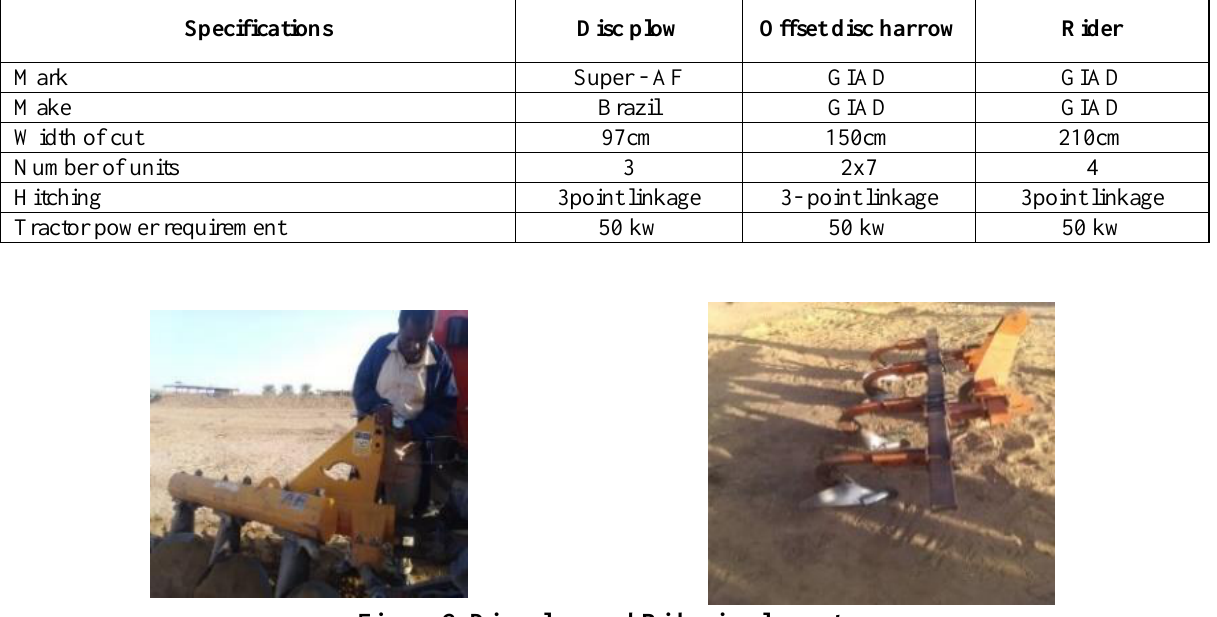
Figure 2. Disc plow and Rider implements Table 3. Technical specifications of the